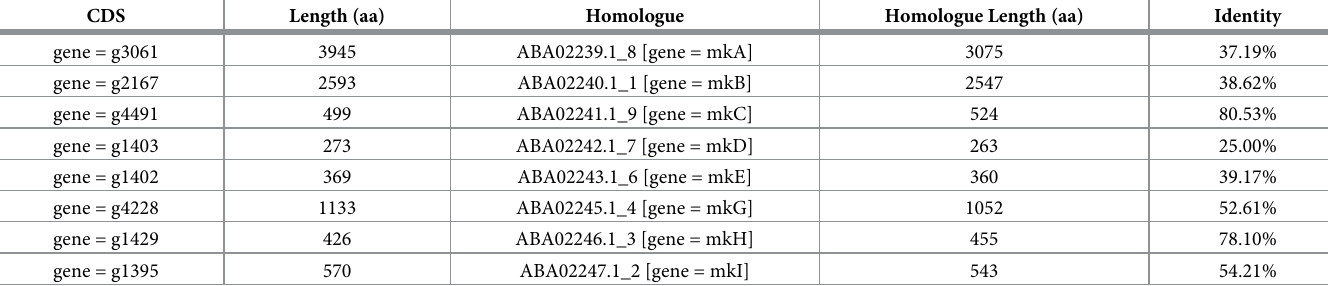
Table 5. Functional prediction of genes detected in the monacolin K BGC of M . purpureus CSU-M183 by NCBI-BLASTP.